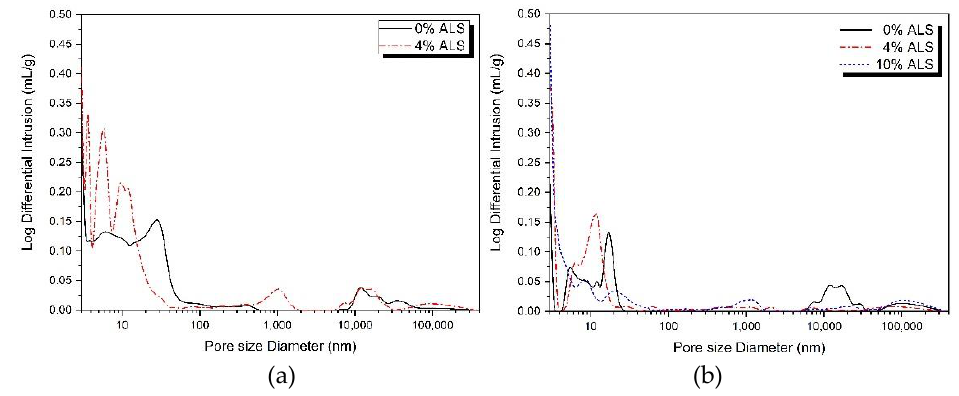
Figure 6. Pore structure analysis: ( a ) 5% alkali + ALS and ( b ) 10% alkali + ALS.